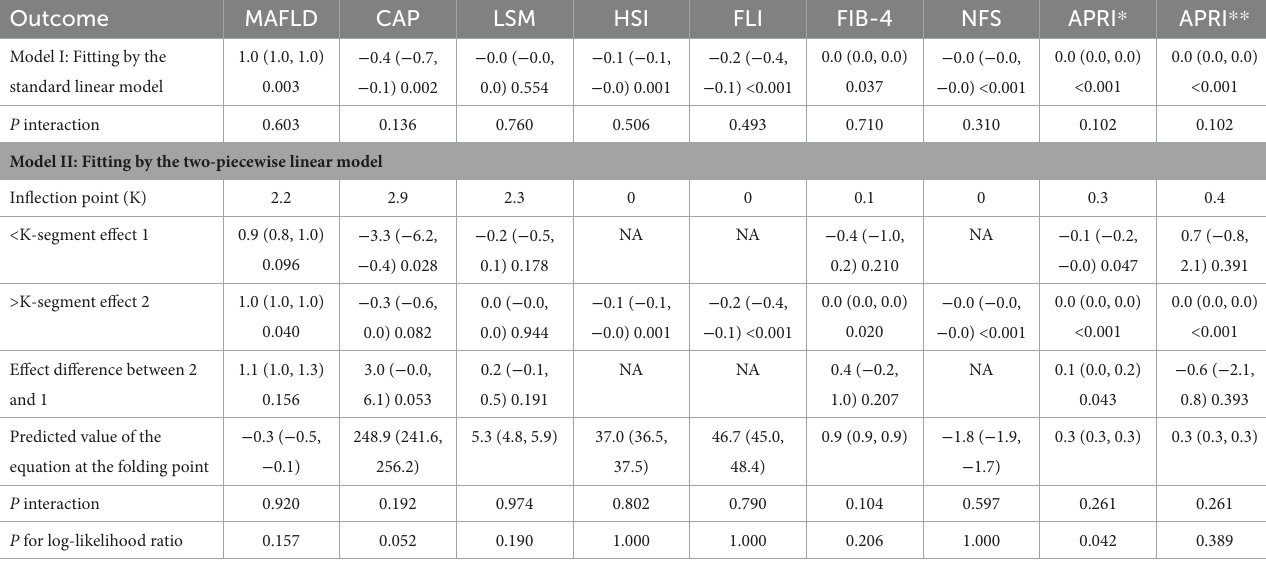
TABLE 3 Threshold effect analysis of daidzein intake using two-segment linear regression models for MAFLD prevalence, APRI, CAP, LSM, FIB-4, NFS, FLI, and HSI, respectively. Outcome MAFLD CAP